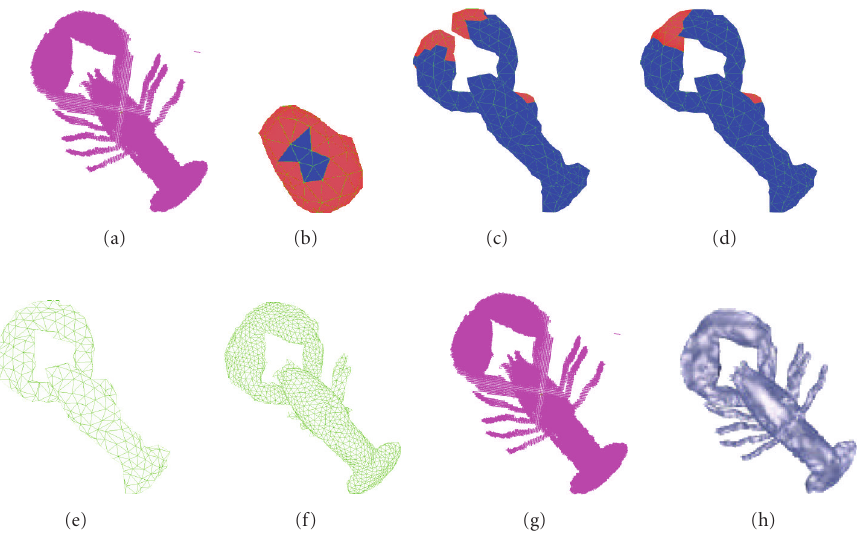
Figure 5: Segmentation of a CT volumetric dataset of a lobster.